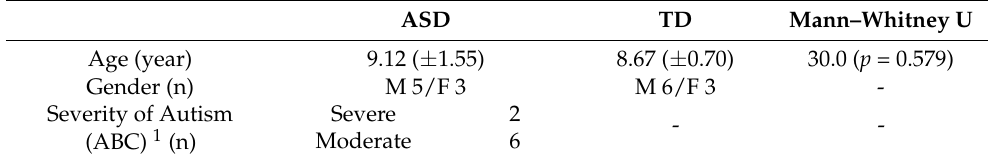
Table 1. Demographic characteristics.